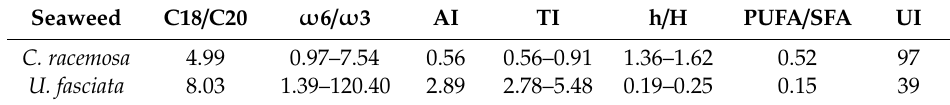
Table 3. Nutritional quality indexes of fatty acids from Caulerpa racemosa and Ulva fasciata .